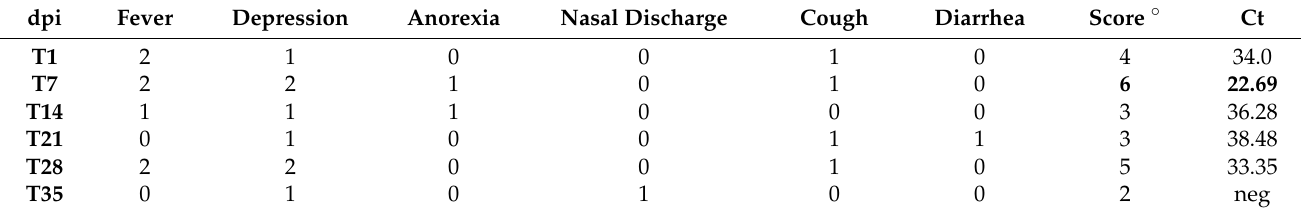
Table 2. Evaluation of clinical score and RT-qPCR Ct values. High rectal temperature and depression showed the best association with nasal shedding. The highest overall clinical score (in bold) observed at T7 is correlated with the high viral RNA detection (in